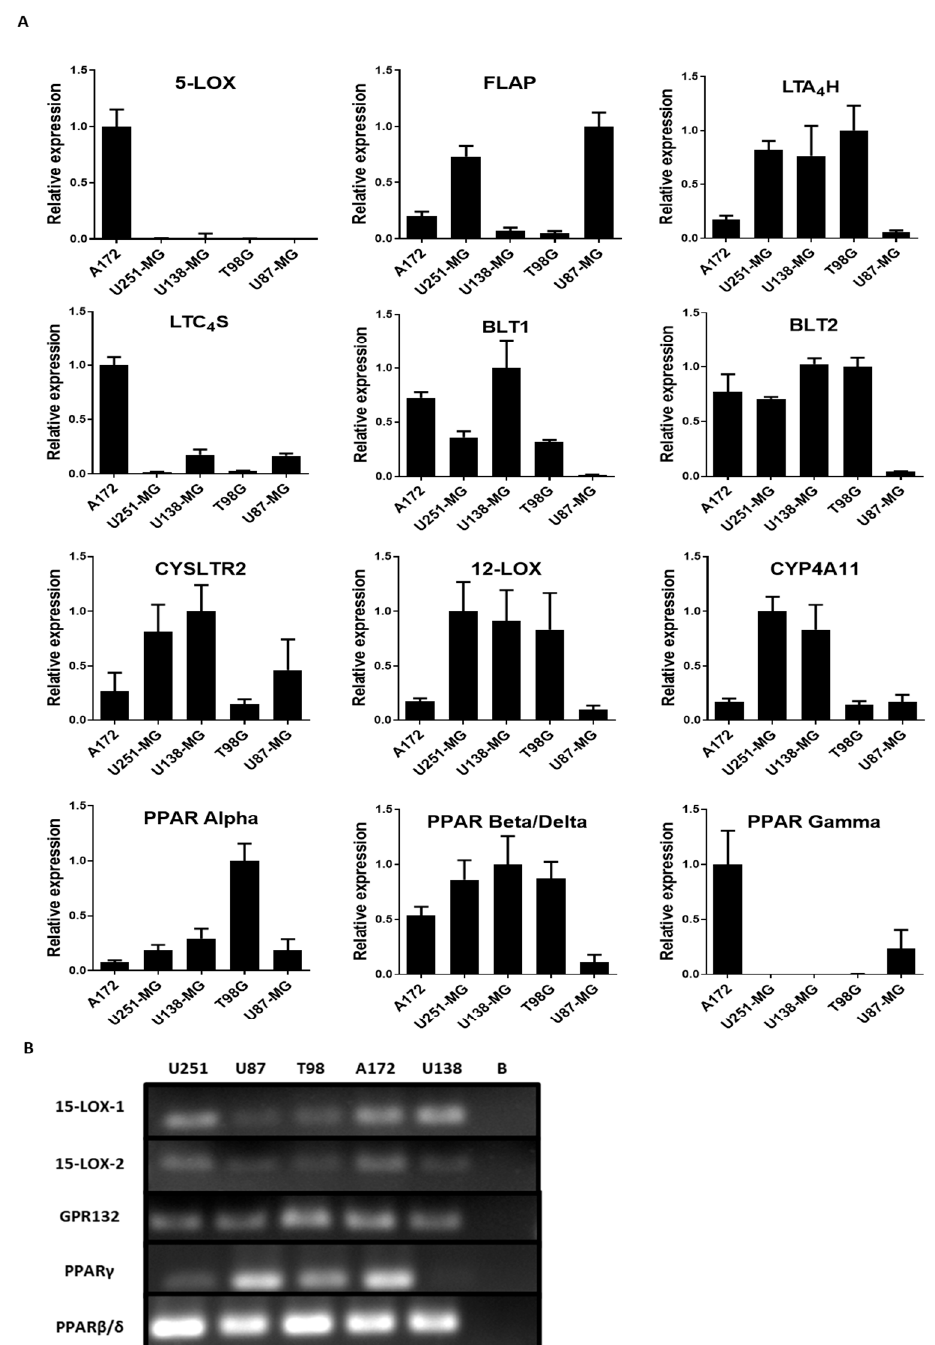
Figure 2. Profile of the lipoxygenase pathway metabolism in 5 glioblastoma (GBM) cell lines. ( A ) qRT-PCR of the enzymes and receptors involved in lipoxygenase and cytochrome P450 (CYP450) pathways in a GBM cell line. Histograms show the relative expression of the genes for: 5-LOX, FLAP, LTA 4 hydrolase (LTA4H), LTC 4 synthase (LTC4S), BLT1, BLT2, CYSLTR2, 12-LOX, CYP4A11, peroxisome-proliferator-activated receptor (PPAR) alpha, PPAR beta / delta, and PPAR gamma. Values represent the genetic expression relative to the endogenous 18S and the standard deviations calculated by ∆∆ CT. N = 3, in duplicate. ( B ) PAGE of conventional RT-PCR of the 15-LOX pathway in five GBM cell lines. Cell lines U251-MG, U87-MG, T98G, A172, and U138-MG were used to identify the genes associated with the 15-LOX pathway. All the genes were amplified in all cell lines, except PPAR γ (gamma) in U138-MG. Blank ( B